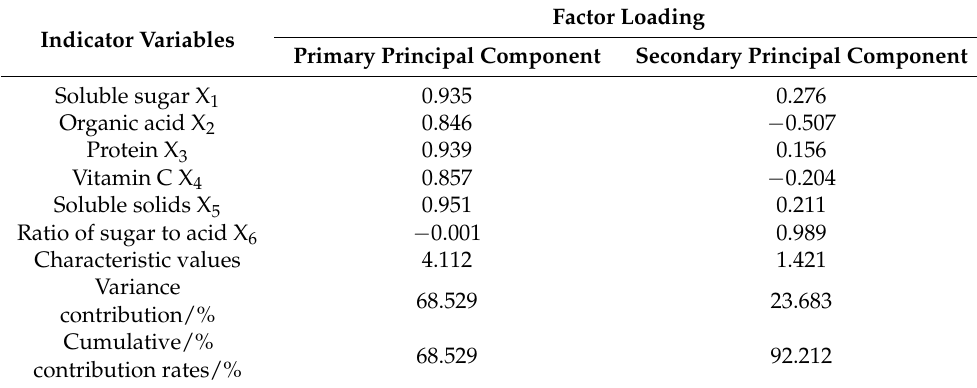
Table 4. Factor loadings and variance contribution rates of the principal components.